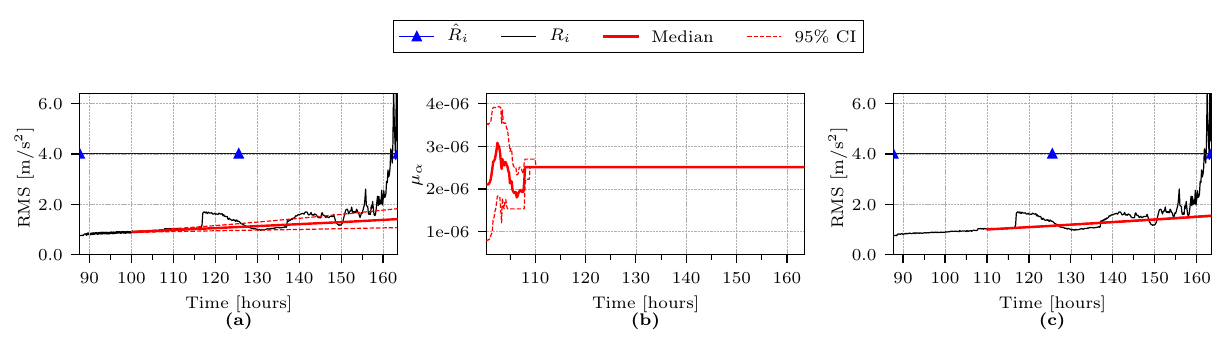
Figure 11: R and initial median and 95% CI output of the corresponding PF. (a) R 1 optimization input, blue line for FT, and red lines for median and 95% CI of PF; (b) α over time for the initiated PF; (c) predicted PF trend when µ